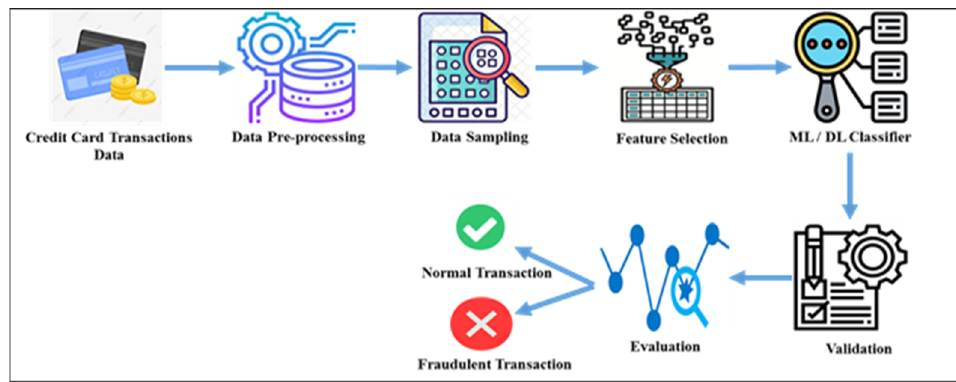
Figure 1. Credit card fraud detection process.